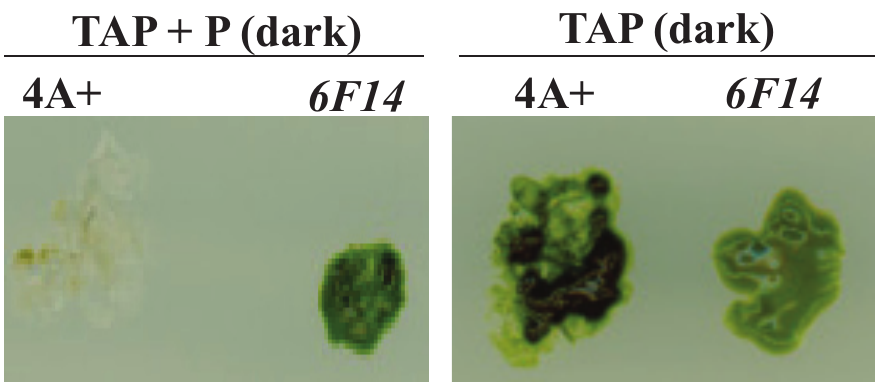
Figure 3. Identification of 6F14 . This figure shows the phenotypic difference of 6F14 compared to the parental strain, 4A+ on heterotrophic agar media (TAP) plates under two different growth conditions: dark + paromomycin (P) and